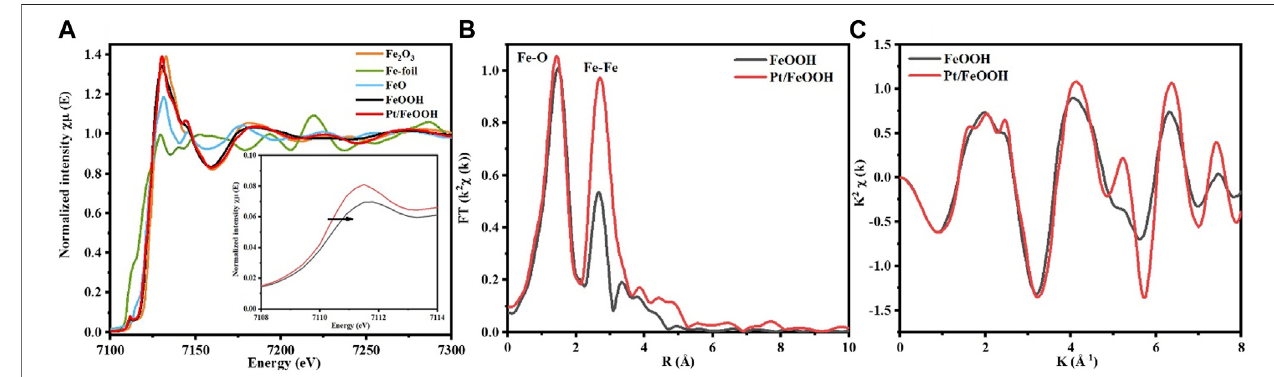
FIGURE 5 | Normalized XANES spectra (A), Fourier-transformed k 2 -weighted of the Fe K-edge EXAFS spectra in R-space (B), and Fe K-edge EXAFS oscillation function k 2 χ (k) in K-space (C) of FeOOH (black) and Pt/FeOOH (red).